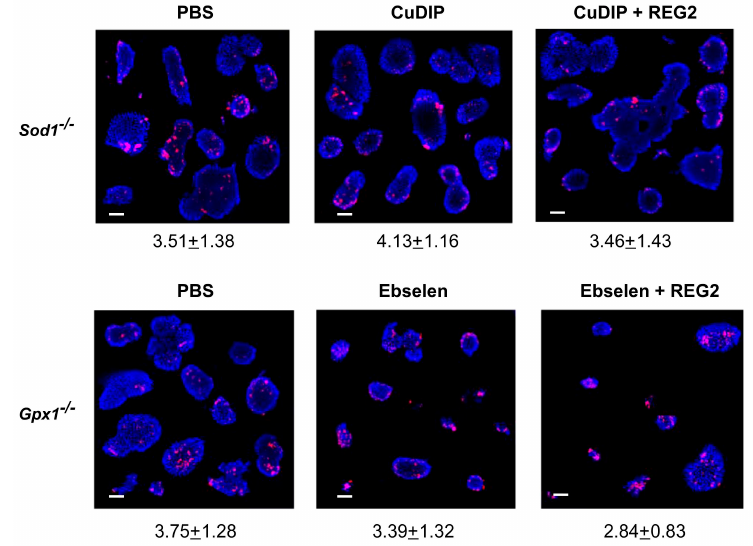
Figure 3. Effects of co-incubation with GPX mimic ebselen or SOD mimic CuDIP on the REG2-mediated inhibition of islet proliferation measured by the BrdU (red) immunostaining in the Gpx1 -/- and Sod1 -/- islets. Numbers under the image panel represent relative BrdU fluorescent intensity. Data were analyzed using Student’s t test within each genotype. Images are representative of replicated experiments: n = 3–4. Scale bar = 50 µm.